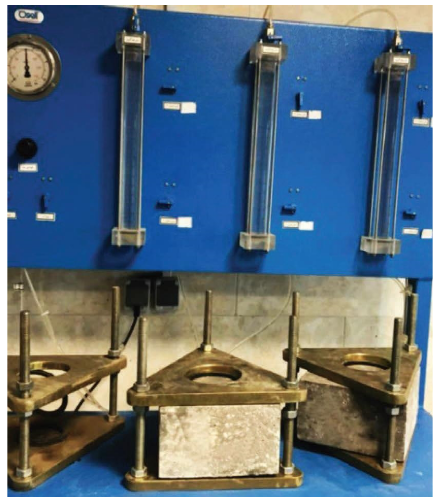
Figure 4: Water penetration